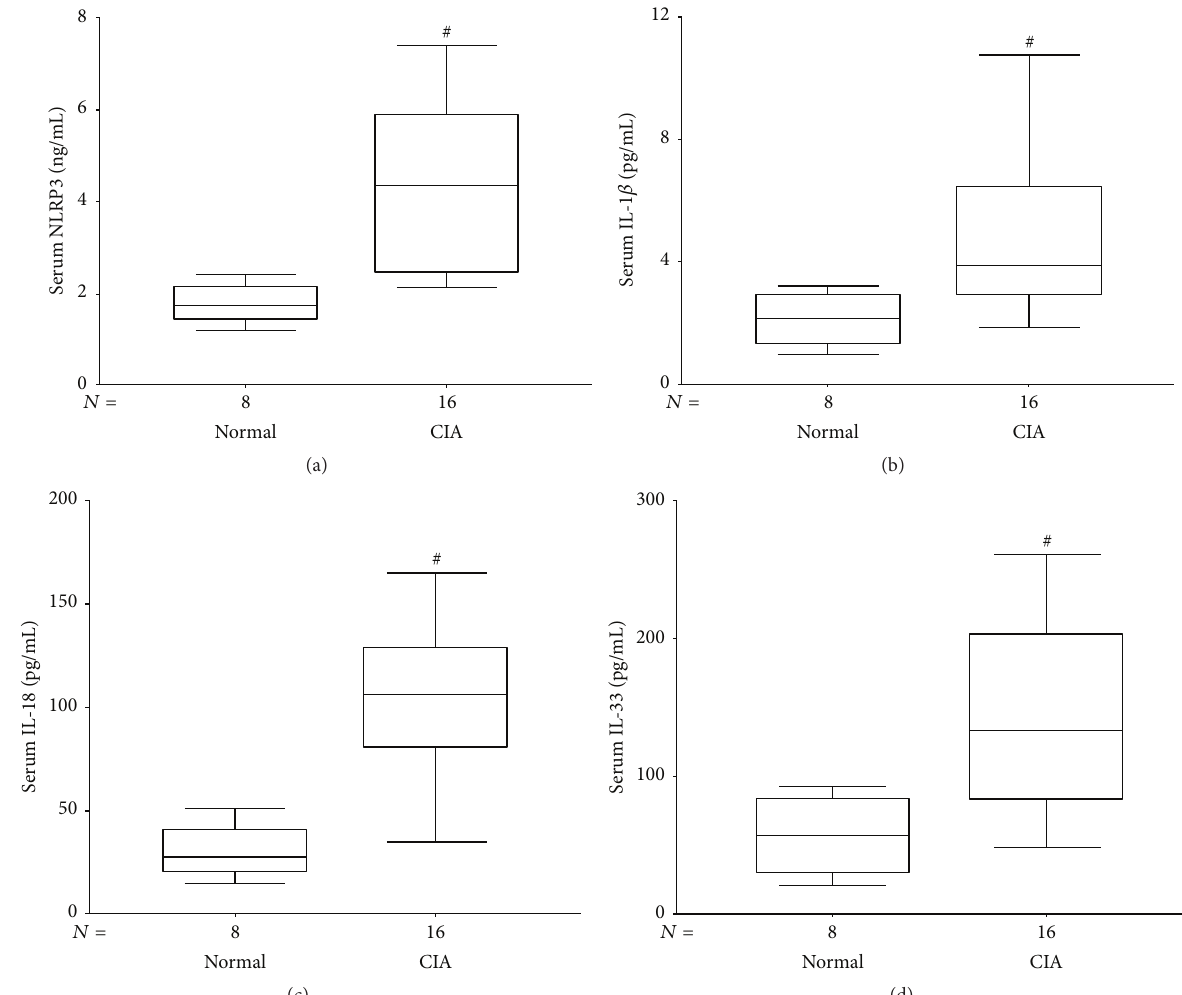
Figure 5: Serum cytokine levels in Normal and CIA groups. (a) The median serum NLRP3 levels in the Normal and the CIA groups were 1.73 ng/mL and 3.44 ng/mL, respectively, 𝑃 = 0.001 . (b) The median serum levels of IL-1 𝛽 in the Normal and the CIA group were 2.14 pg/mL and 2.82 pg/mL, respectively, 𝑃 = 0.005 . (c) The median serum levels of IL-18 in the Normal and the CIA group were 27.67 pg/mL and 30.60 pg/mL, respectively, 𝑃 = 0.000 . (d) The median serum levels of IL-33 in the Normal and the CIA group were 61.09 pg/mL and 67.15 pg/mL, respectively, 𝑃 = 0.004 . # 𝑃 < 0.05 , compared with the Normal